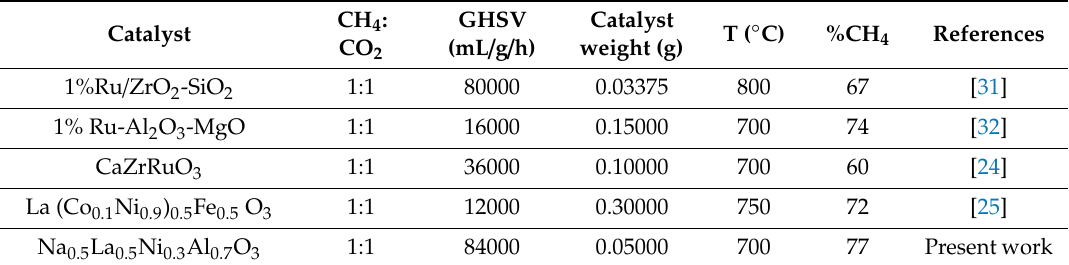
Table 1. Comparison between the CH 4 conversion obtained and those from data available in literature for di ff erent catalysts used in dry reforming of CH 4